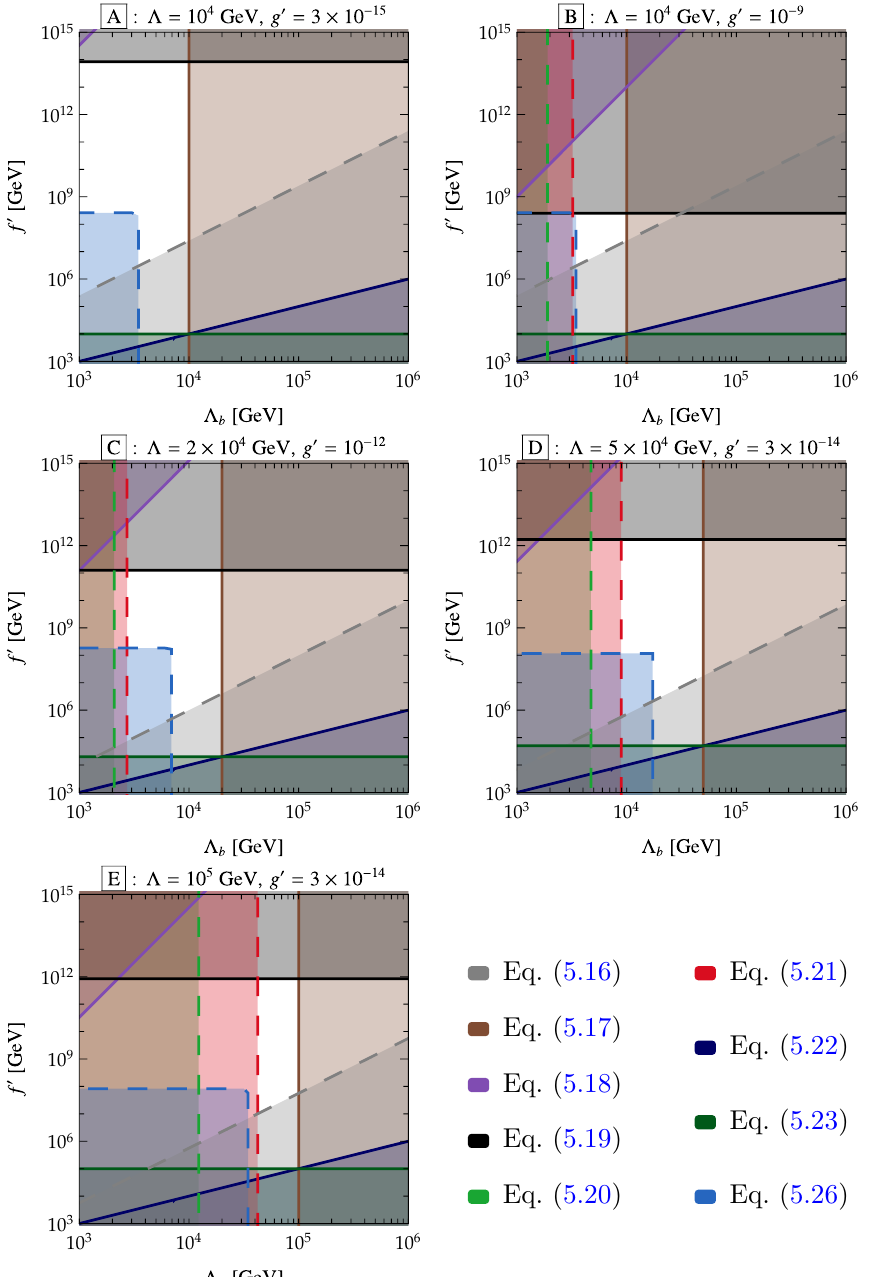
Figure 9 . Constraints on the f 0 (cid:0) (cid:3) b plane from eqs. (5.16){(5.23), (5.26) for the (cid:12)ve benchmark cases listed in eq. (5.28). The dashed lines correspond to the bounds which rely on conservative assumptions about the thermalisation process.